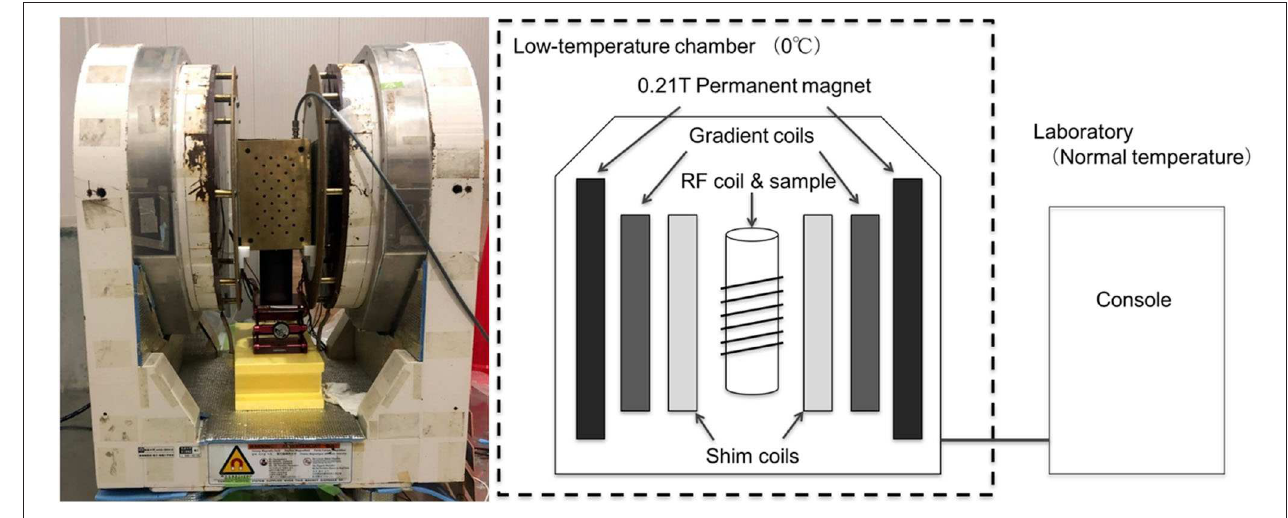
FIGURE 1 | Photograph and schematic diagram of a C-MRI.